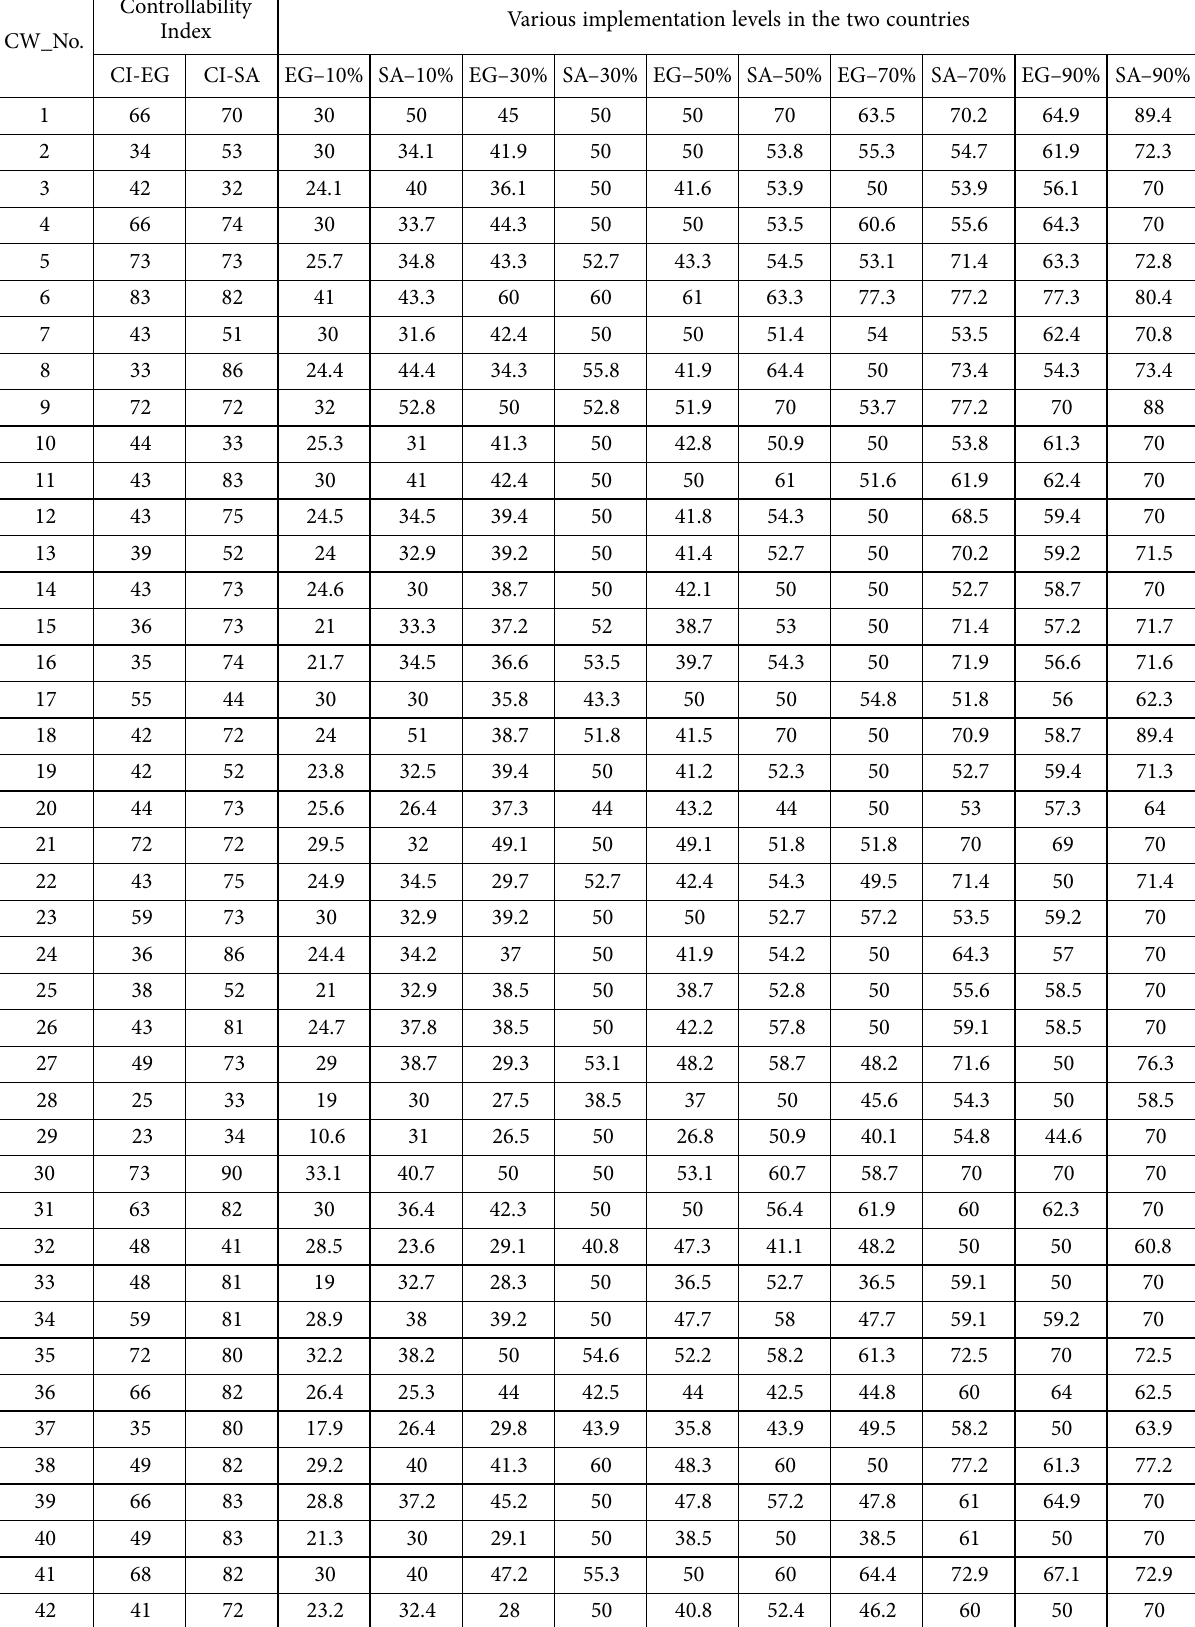
Table 8. Lean effect at various implementation levels in the two countries countriesControllability Various implementation levels in the two Index